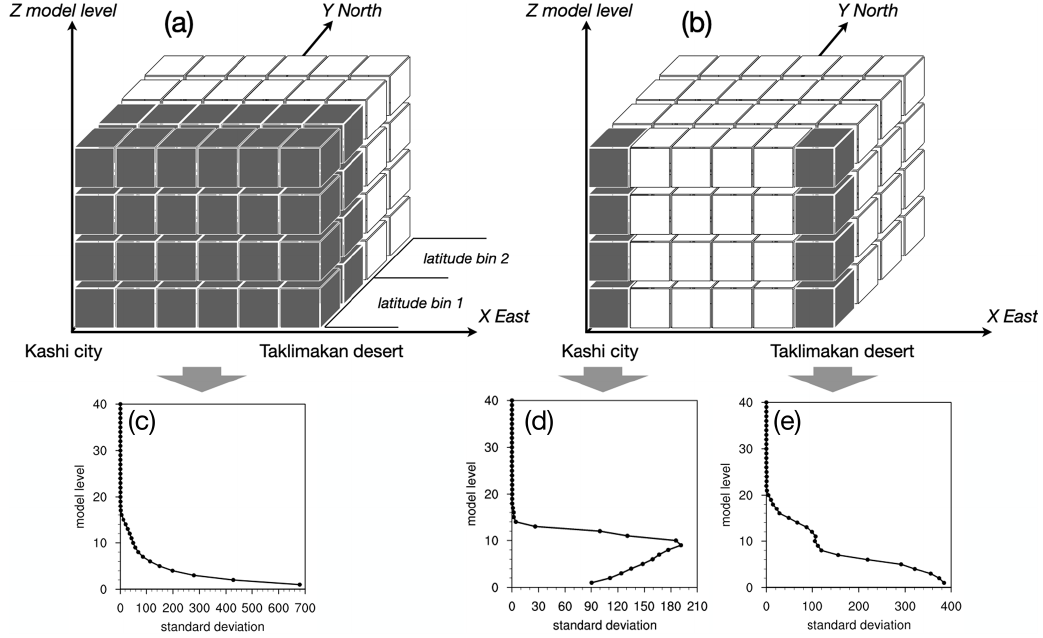
Figure 2. Schematic diagram of the binning strategy for modeling background error covariance matrix on (a) the latitude-binning data or (b) the gridded data; and the vertical profiles of standard deviations (µgkg − 1 ) of the fourth size bin OIN component concentration at 06:00UTC over a few mild dust episodes in April 2019 (c) on average over the latitude bins, (d) at Kashi city grid, and (e) at the Taklimakan desert grid (i.e., 1.5 ◦ east of Kashi city).